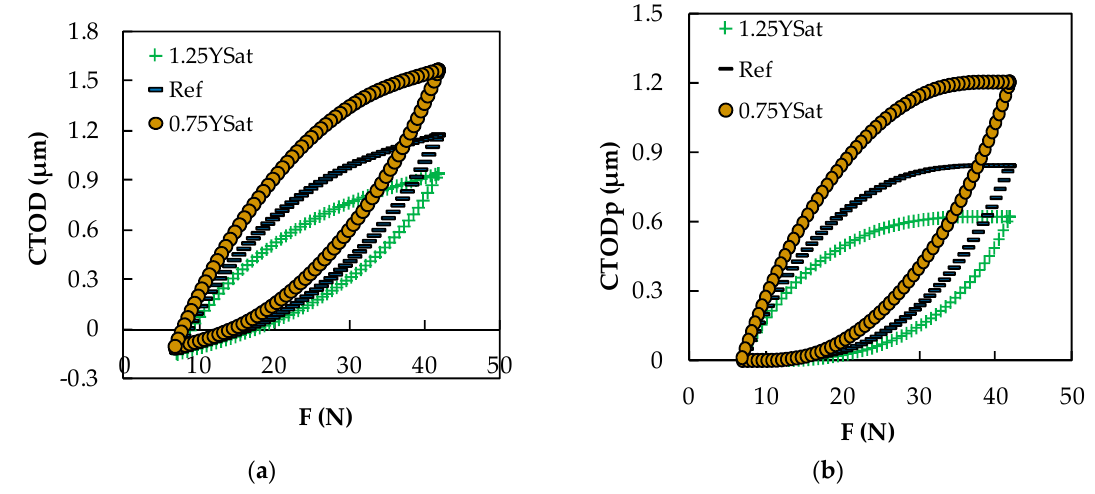
Figure 3. ( a ) Total CTOD vs. load; ( b ) Plastic CTOD vs. load. (SS304L isotropic; without crack closure).